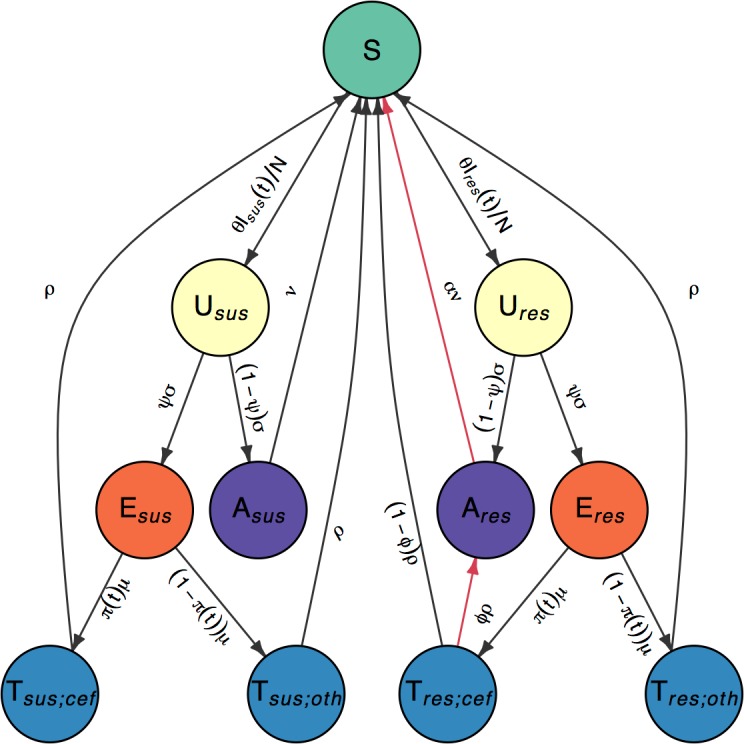
Flow diagram of model compartments with rates of transition between infection states.Susceptible individuals (S) become infected with either cefixime-susceptible (s = sus) or cefixime-resistant strains (s = res). Infections initially pass through an incubation period (Us) before the individuals with the infection either develop symptoms (Es) or remain asymptomatic carriers (As). Symptomatic individuals seek treatment (Ts;p) and are prescribed either cefixime (p = cef) or another antibiotic (p = oth). The 2 sides are symmetric with the exception of the 2 arrows highlighted in red, which correspond to the cost and the benefit of resistance.